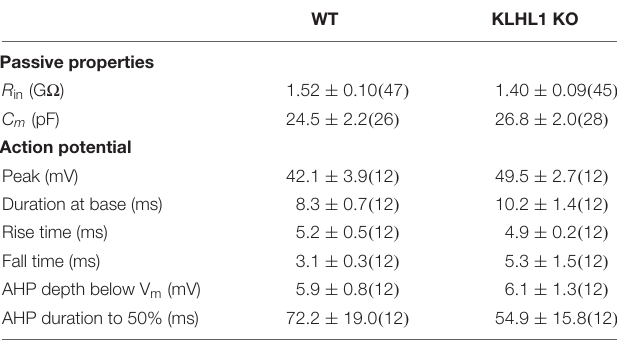
AHP, after-hyperpolarization. The input resistance (R in ), the capacitance (C m ) and the shape of single action potential in hypothalamic neurons were not significantly different between genotypes. P > 0.05,